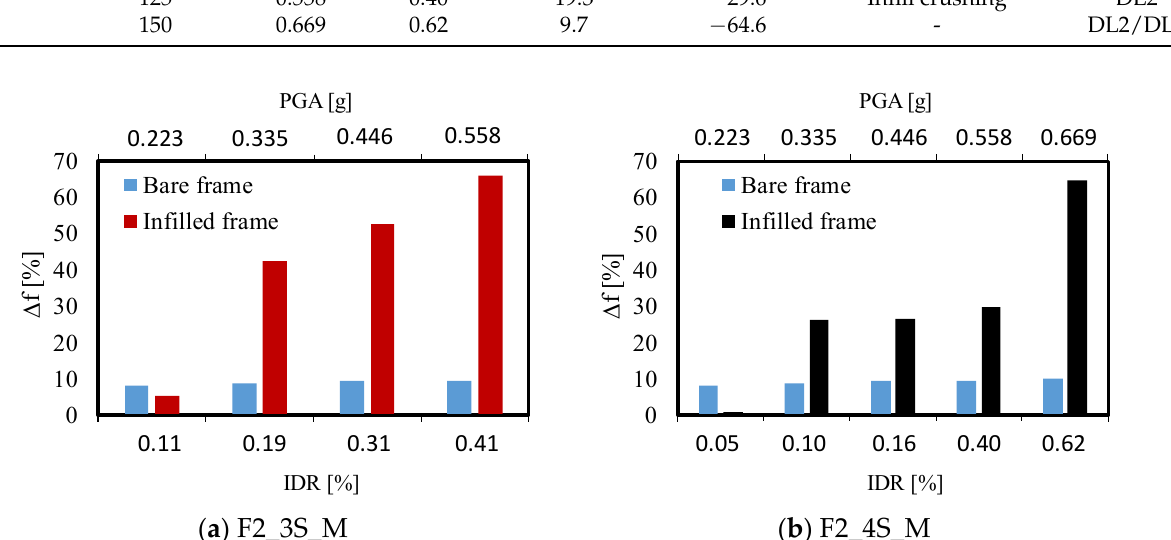
Figure 8. Comparison of the variation in fundamental frequency from the FE model between bare and in fi lled frames F2_3S_M ( a ) and F2_4S_M ( b ).